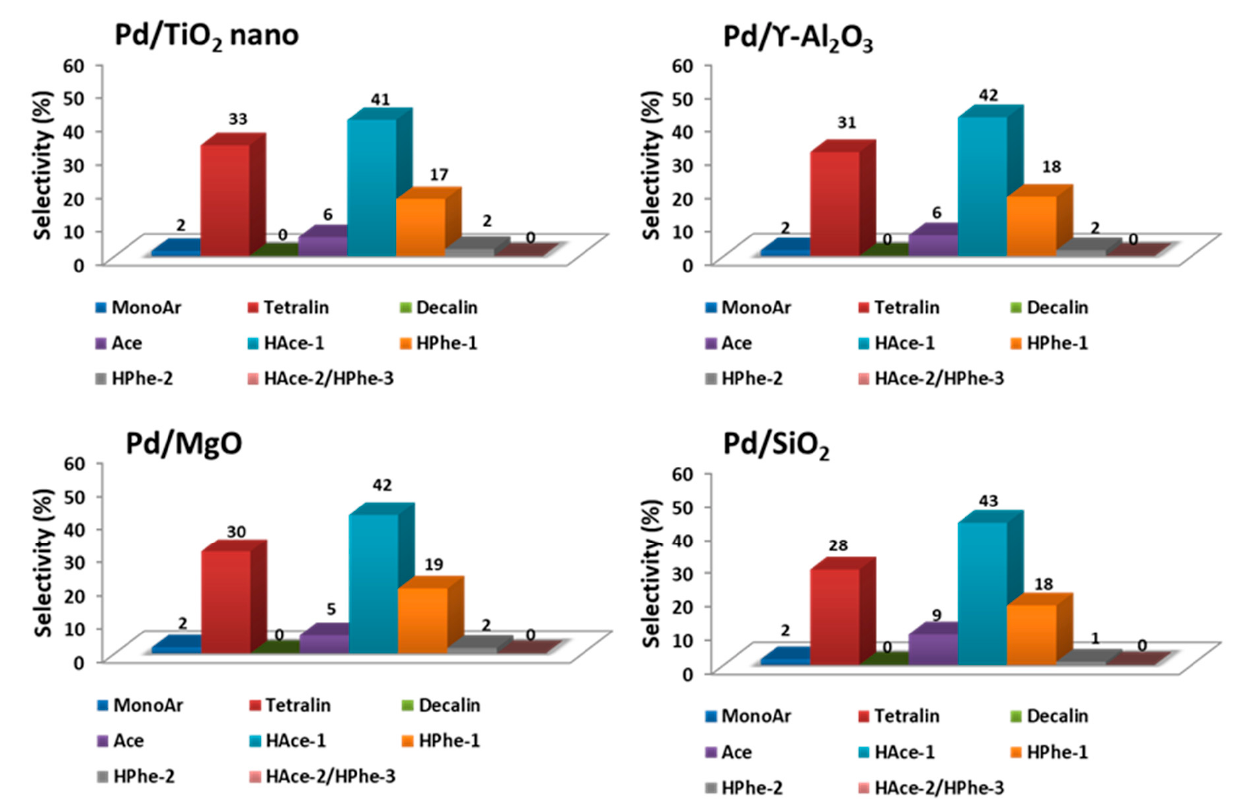
Figure 2. Selectivity to the different groups of products for metal oxides-supported Pd catalysts compared at 54–57% conversion. Reaction conditions: 0.5 g of tars-type compounds, 4 g of n-hexadecane, 0.2 g of catalyst at 250 °C and 30 bar of H 2 during 7 h.